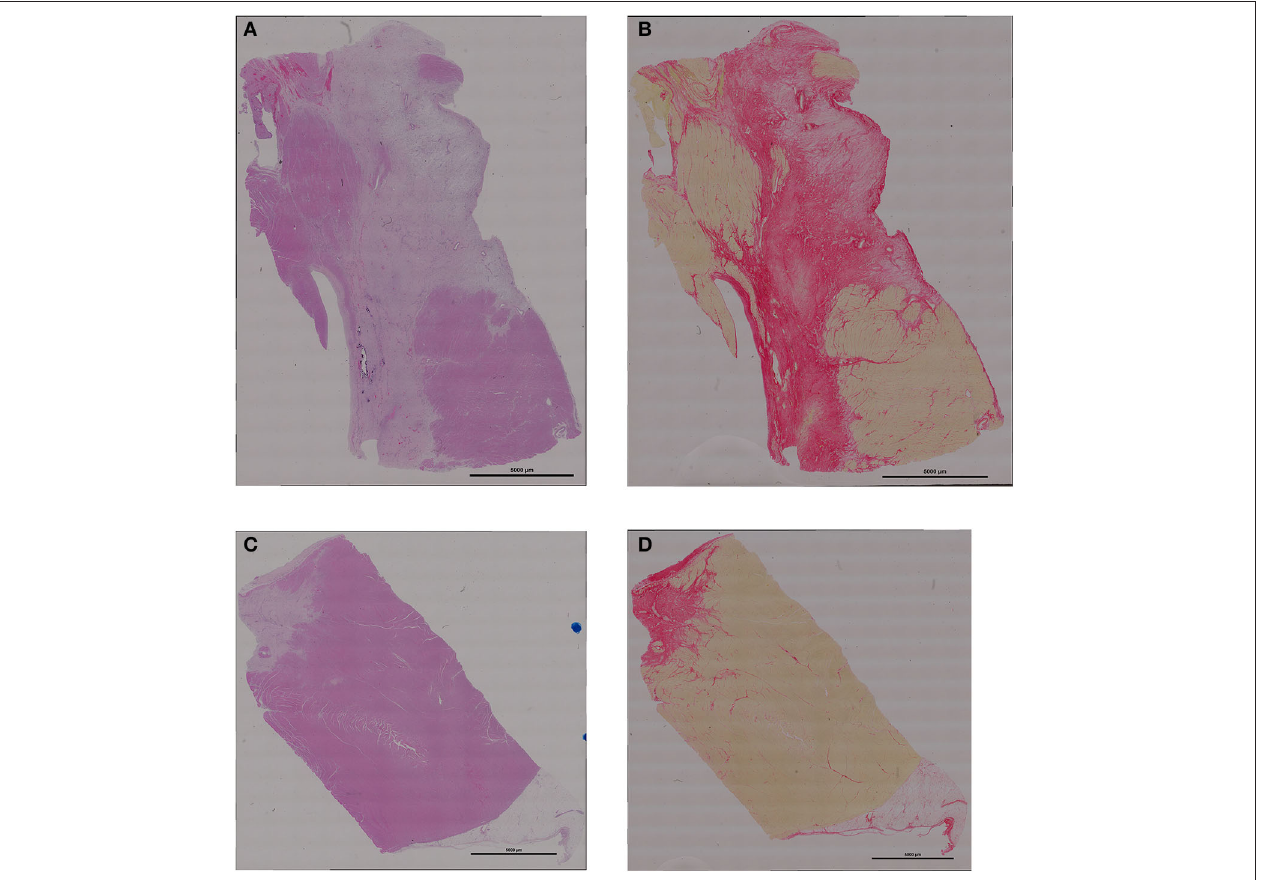
FIGURE 4 | Representative examples of histology of the infarct region (A) H&E staining from control treated pig; (B) picrosirius red staining from control pig; (C) H&E from exosomes treated pig; (D) picrosirius red from exosomes pig. Scale bar for all images is 5000 um long.